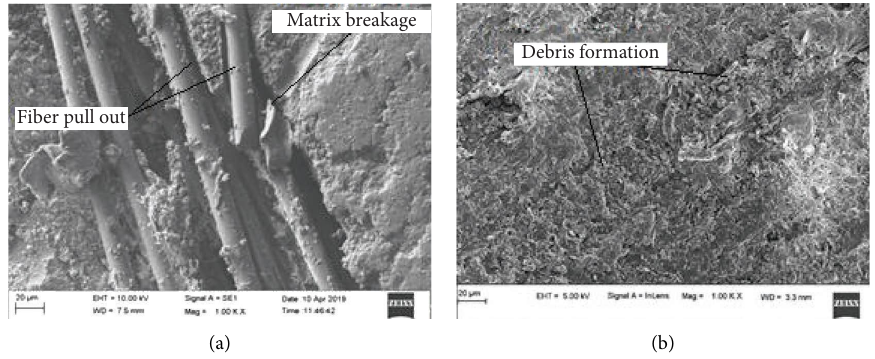
Figure 16: SEM results of wear samples at 1.0% of Al